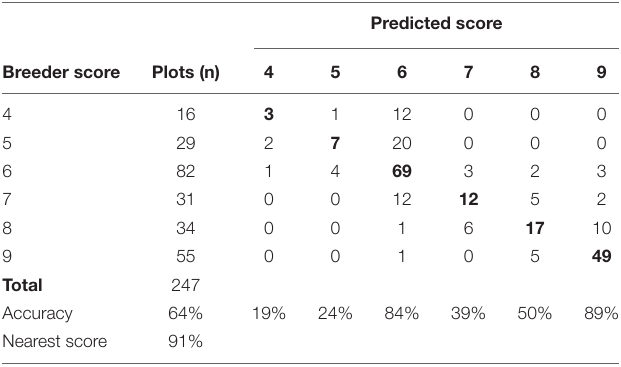
TABLE 7 | Classification confusion matrix of LLS visual scores and model predicted scores of the training data set collected at Nakabango. Predicted score